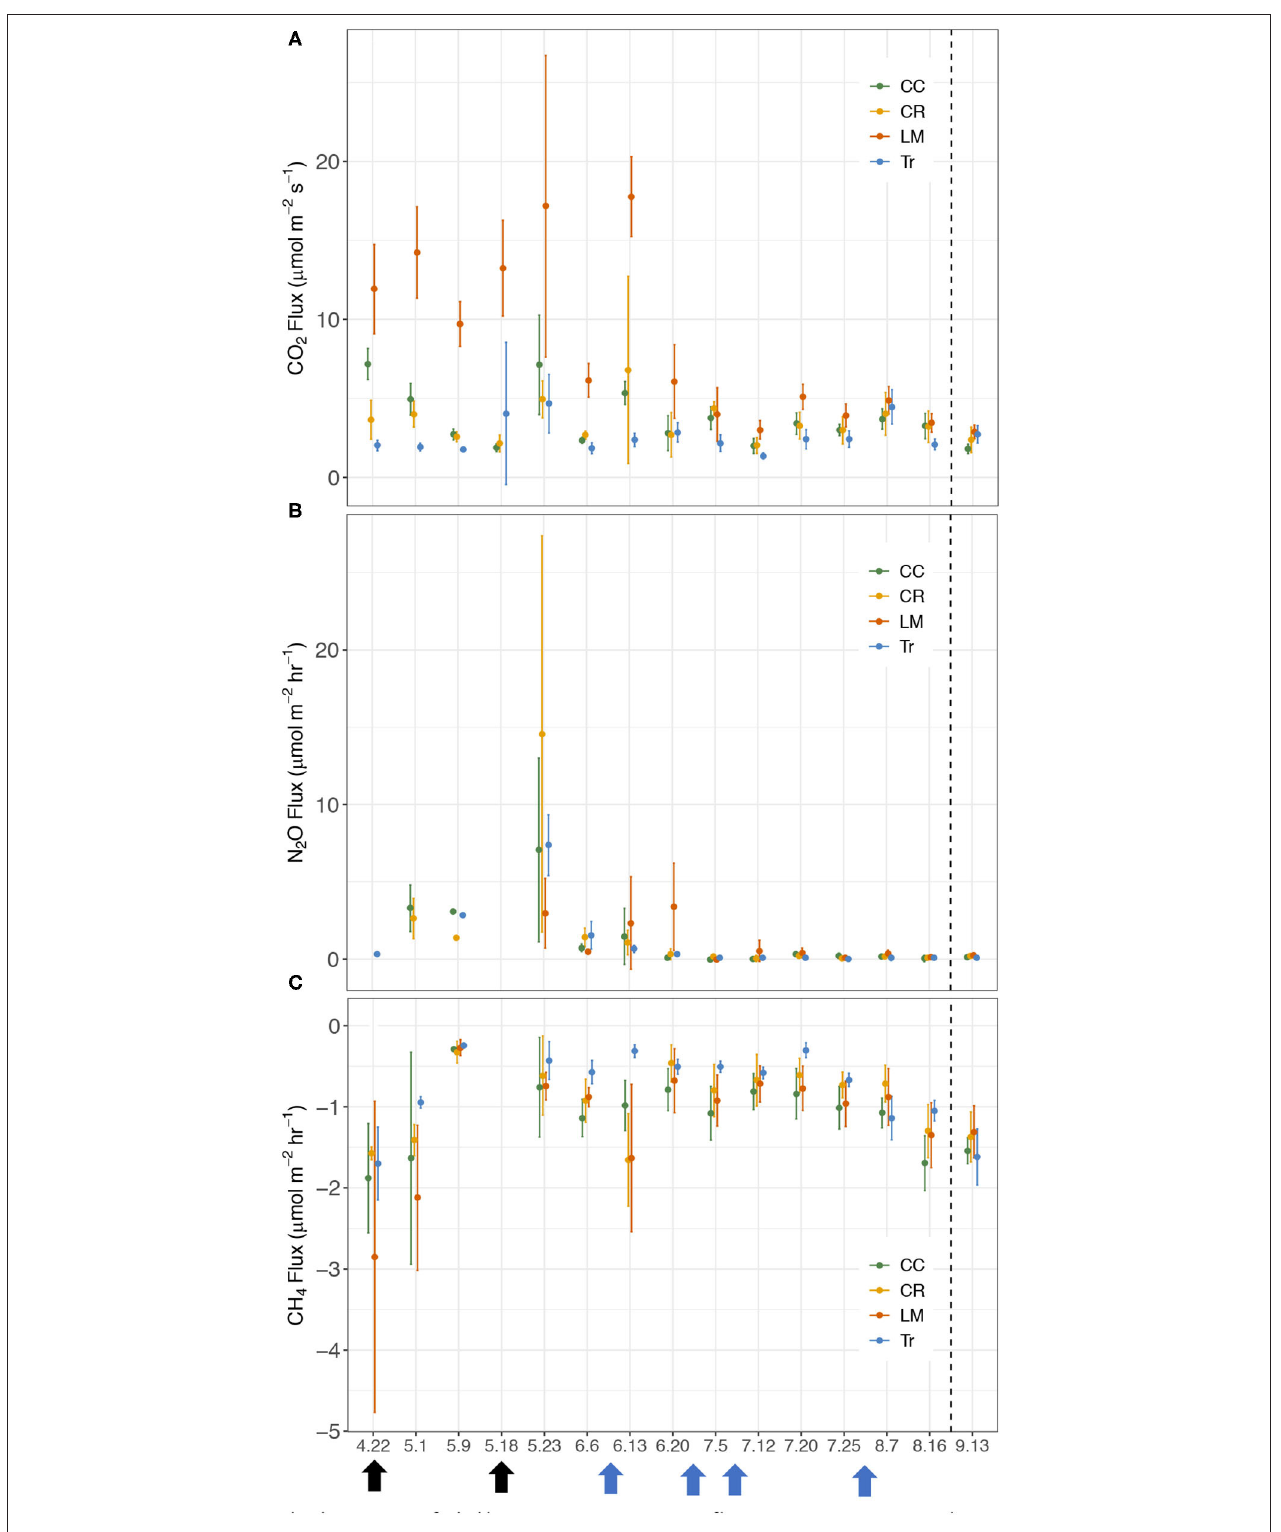
FIGURE 2 | Temporal changes of daily average GHG fluxes between the maize rows in 2018 growing season for crimson clover (CC), cereal rye (CR), white clover living mulch (LM), and conventional (Tr) practices. (A) CO 2 ( µ mol m − 2 s − 1 ), (B) N 2 O ( µ mol m − 2 hr − 1 ), (C) CH 4 ( µ mol m − 2 hr − 1 ). Black arrows represent two fertilizer applications (4/22 and 5/18) and blue arrows represent four irrigation events (6/11, 6/22, 7/6, and 7/31).